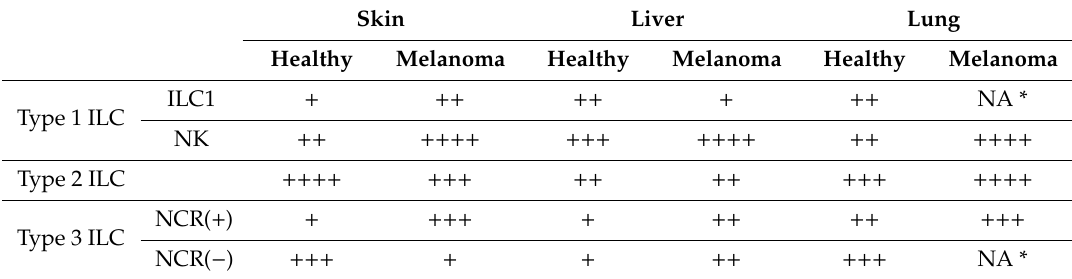
Table 1. Relative abundance of ILCs in skin, liver and lung.